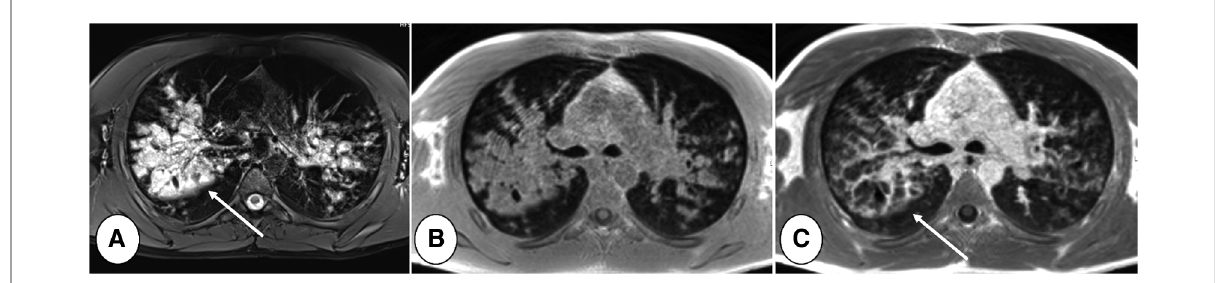
FIGURE 9 16 years old boy with cystic fi brosis during respiratory tract exacerbation. T2-weighted PROPELLER image ( A ), T1-weighted ( B ) pre and post-contrast ( C ) gradient-echo acquisitions, performed on 1.5 T MRI system (MAGNETOM Avanto, Siemens Healthineers, Enlargen, Germany). Note that in T2- weighted scan bronchial wall cannot be identi fi ed in the large bronchiectasis with mucus plugging in the right upper lobe ( A , arrow). Gadolinium injection allows identi fi cation of bronchial wall thickening and to distinguish between bronchial wall and mucus plugs ( C ,